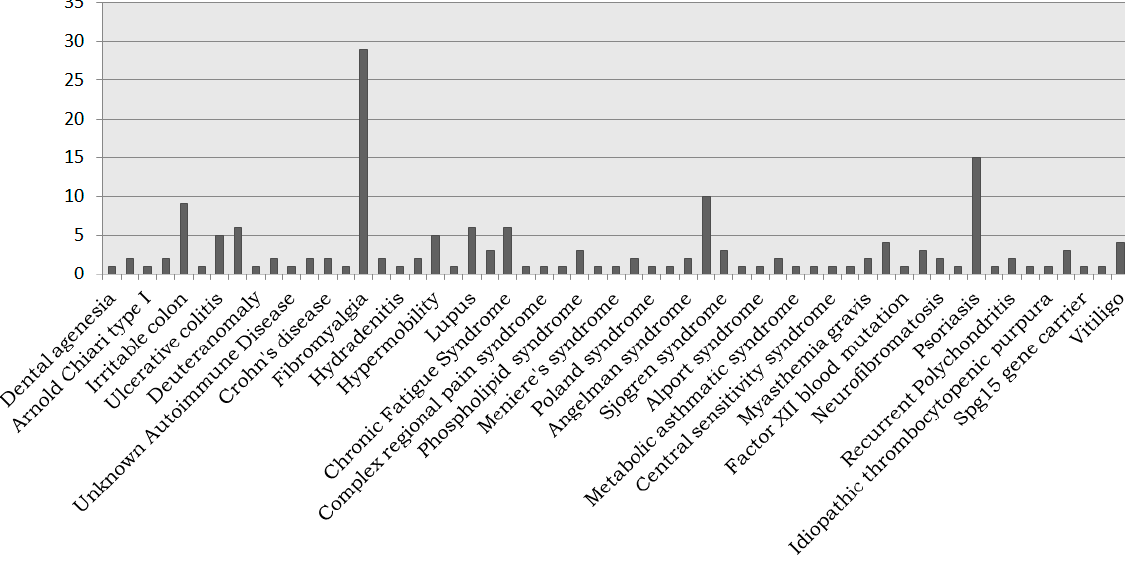
Figure 5. Presence of rare diseases in the Andalusian Registry of Donors for Biomedical Research.